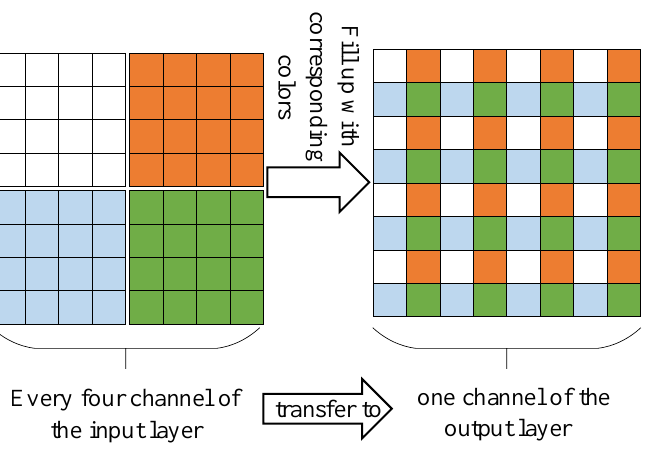
Figure 3. DeFOCUS. The DeFOCUS can transform every four adjacent channels of the input layer as one channel of the output layer and enlarge the size of the input layer by two. In this figure, we used different colors to indicate channels of the feature map that needs to be enlarged by two.